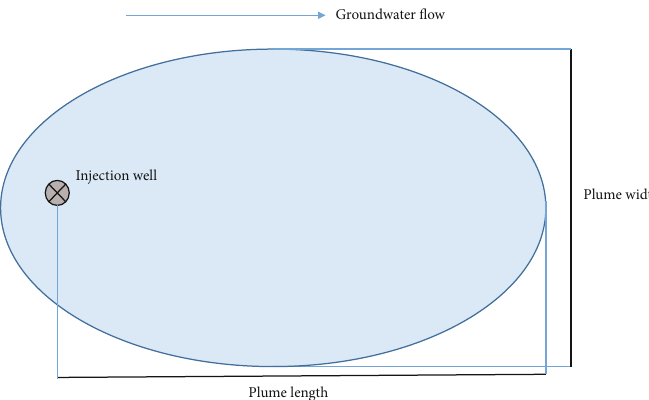
Figure 6: Geometric representation of the TAZ plan view.